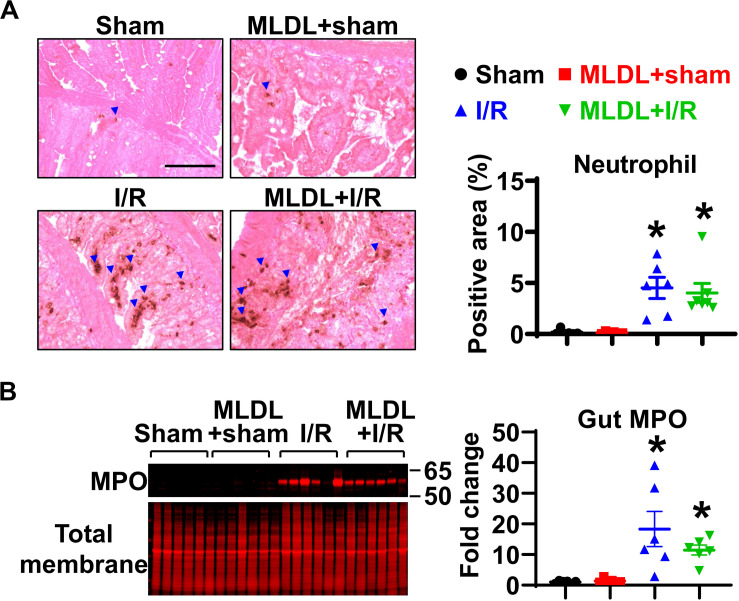
Gut I/R-induced neutrophil infiltration in local tissues is not affected by blocking mesenteric lymph flow. (A) Immunohistochemical staining reveals increased gut neutrophil numbers in I/R, which is not affected by mesenteric lymph duction ligation (MLDL). The blue arrowheads indicate neutrophils (brown dots). Scale bar, 100 μm. (B) Myeloperoxidase (MPO) expression in the small intestine is elevated after I/R, which is not altered by MLDL. n = 6–7/group. *p < 0.05 vs. sham or MLDL + sham. One-way ANOVA was used.